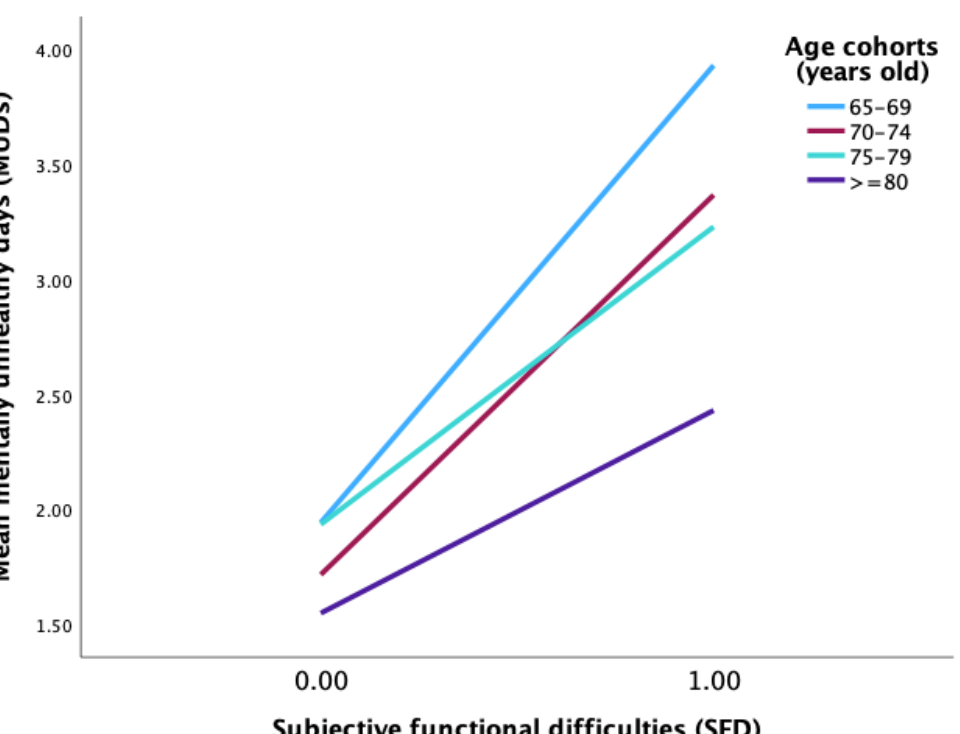
Figure 2. Simple slope analysis showed that the predictive effect of SFD on MUDs was statistically